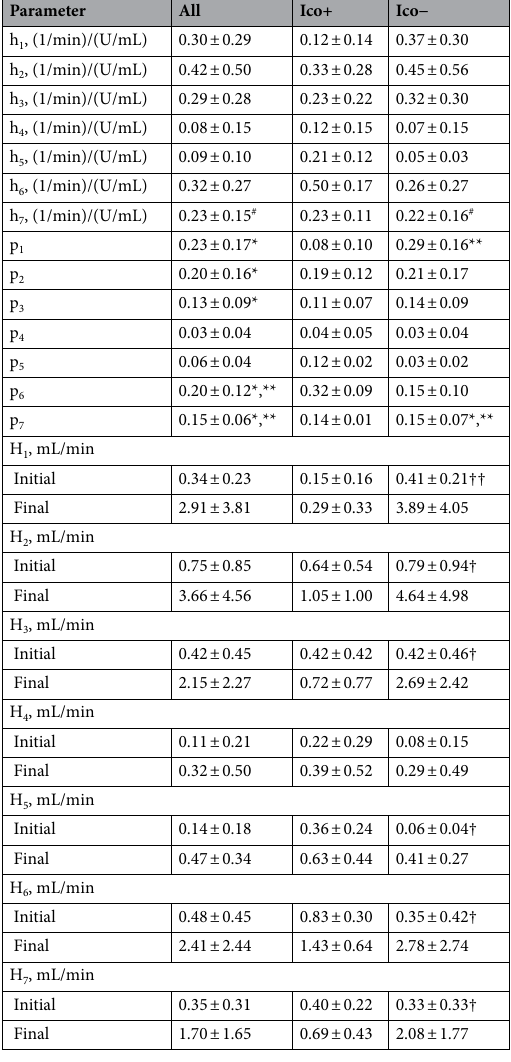
Table 2. Mean ± SD values of hydrolysis rates, h i , hydrolysis probability, p i , and time dependent hydrolytic clearances ( H i initial and final), related to the degradation caused by α-amylase activity, estimated for the extended three-pore model for all patients (All, n = 11) and for Ico+ (n = 3) and Ico− (n = 8) groups. # p < 0.05 for post-hoc Tukey test versus h 4 . *, ** p < 0.05 for post-hoc Tukey test versus p 4 and p 5 , respectively. † p < 0.05 and †† p = 0.052 for ANOVA repeated measurements applied for the comparison between initial and final value of H i for Ico−